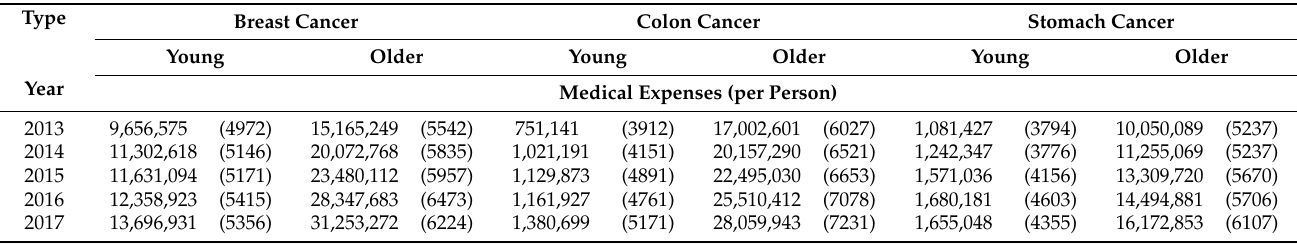
Table 2. Total medical expenses for female cancer survivors in convalescent hospitals by age group between 2013 and 2017 (1000 KRW (cid:59) 1